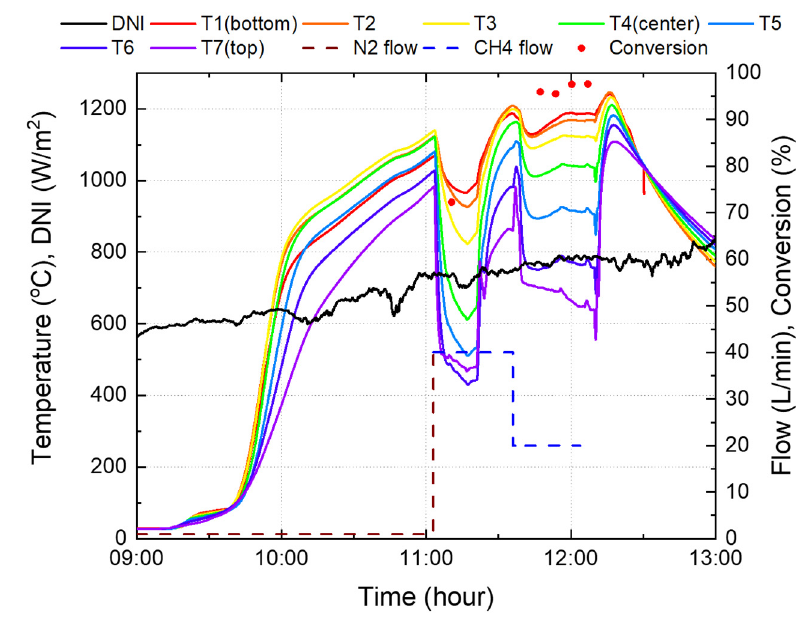
Figure 15. Experimental results using the reactor 2.